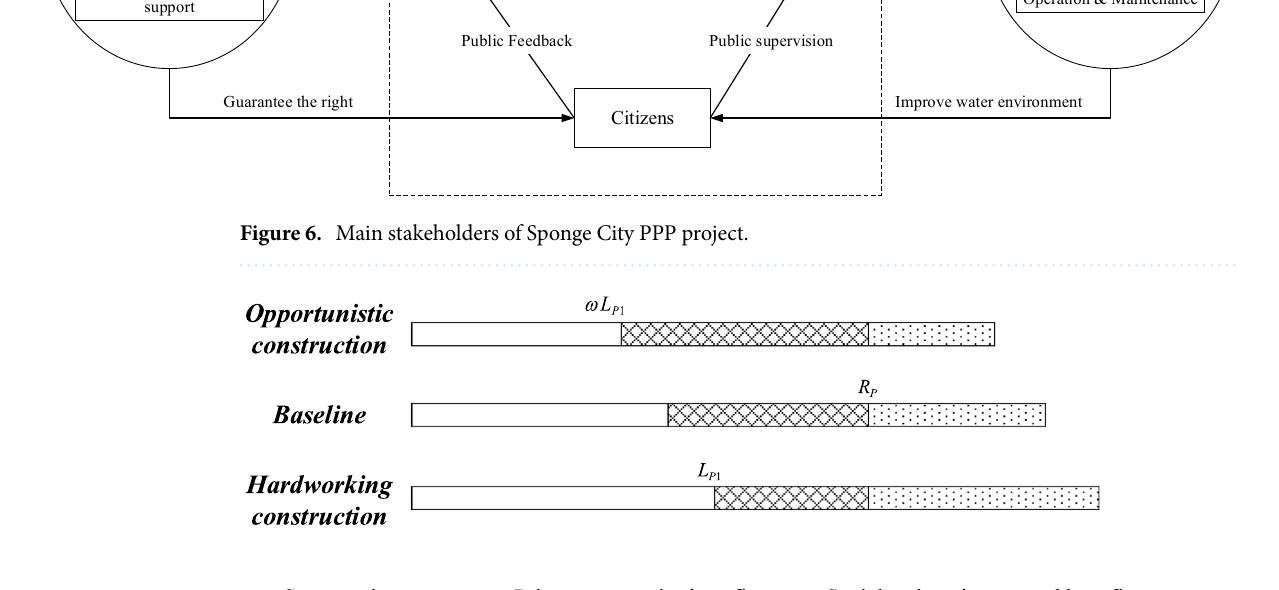
Figure 7. Cost–benefit diagram of opportunistic and hardworking